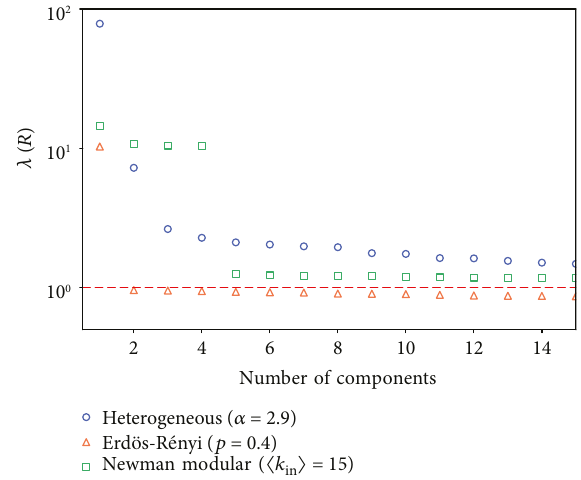
Figure 10: Scree plot, in logarithmic vertical scale, calculated from the correlation matrix, R , for 3 network topologies: Erdös- Rényi (triangular orange markers), heterogeneous (circular blue markers), and Newman modular (squared green markers) networks, with parameters as in Figure 9. A scree plot shows the value of eigenvalues, λ R , in descending order, as components (principal orthogonal directions) are gradually being included (up to the number of variables). λ = 1 is labelled in red, as a possible selection criterion for the number of components or factors. Other used criteria: λ R much larger than the others and describing rather straight angles with successive values. 1-factor model and 4-factor model may be suitable for ER and Newman modular networks, respectively, whereas a more complex model is needed for heterogeneous